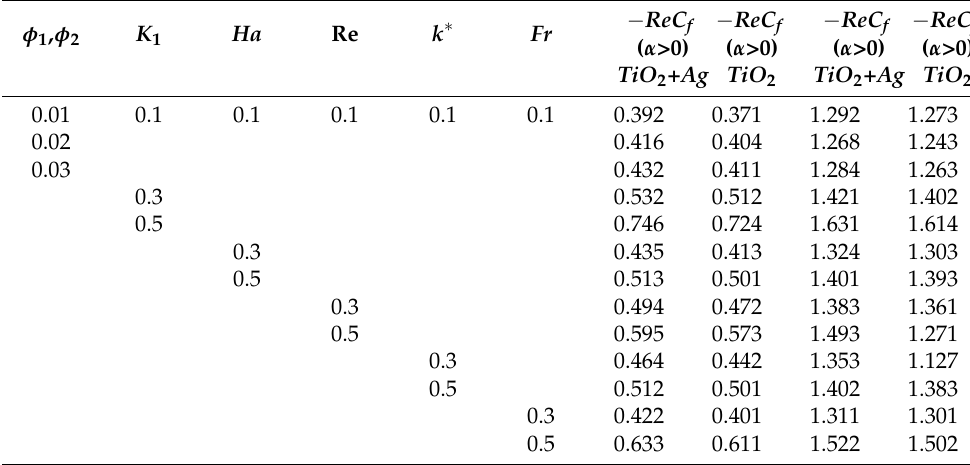
Table 5. The skin friction − ReC f versus different parameters.